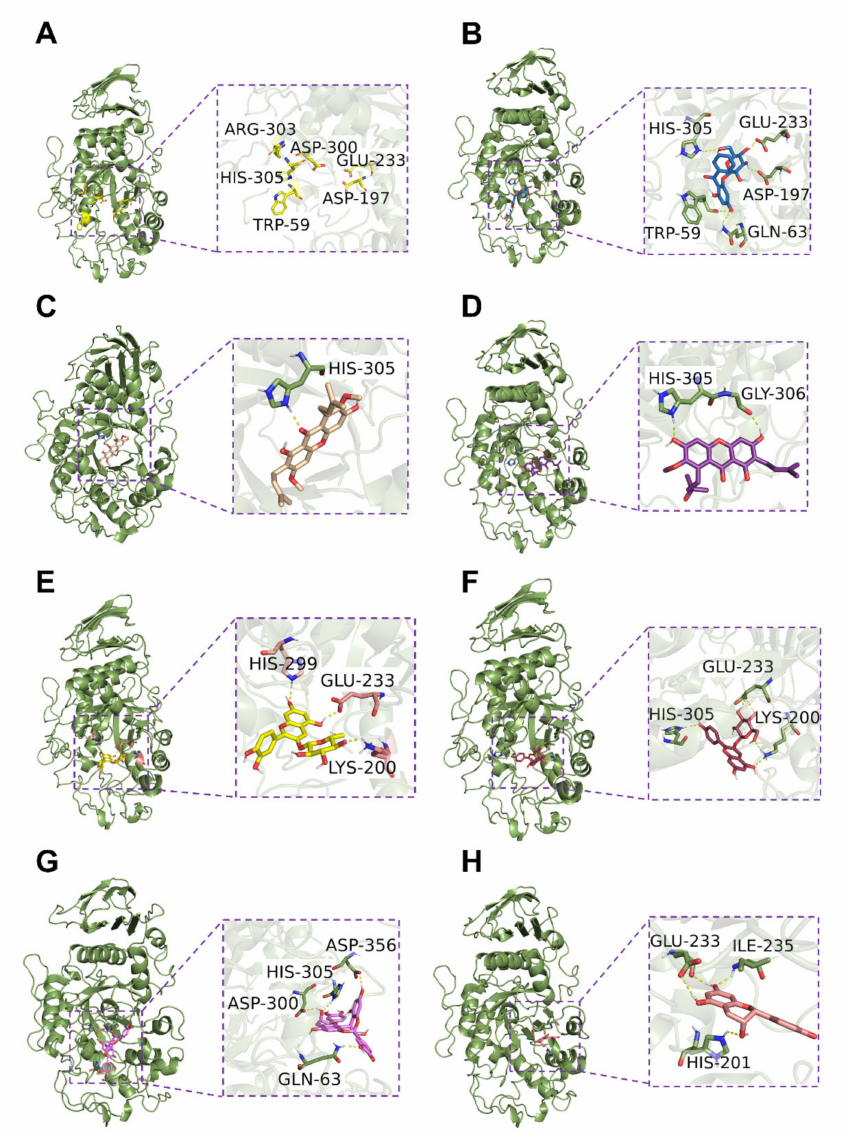
Figure 3. Predicted binding mechanism of α -amylase with representative compounds in MPPs: ( A ) Active sites of human pancreatic α -amylase (PDB ID: 1HNY); ( B ) garcimangosone D; ( C ) β -mangostin; ( D ) garcinone D; ( E ) cyanidin-3- O -glucoside; ( F ) pelargonidin-3- O -glucoside; ( G ) proanthocyanidin A2; ( H ) ( E )